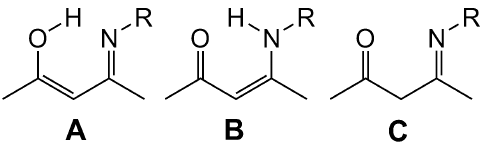
of 1a (Figure 1a) can be compared to that of ( Z )-3-((2,6-diisopropylphenyl)amino)-1-phenylbut-2-en-1-one with which it shares an identical